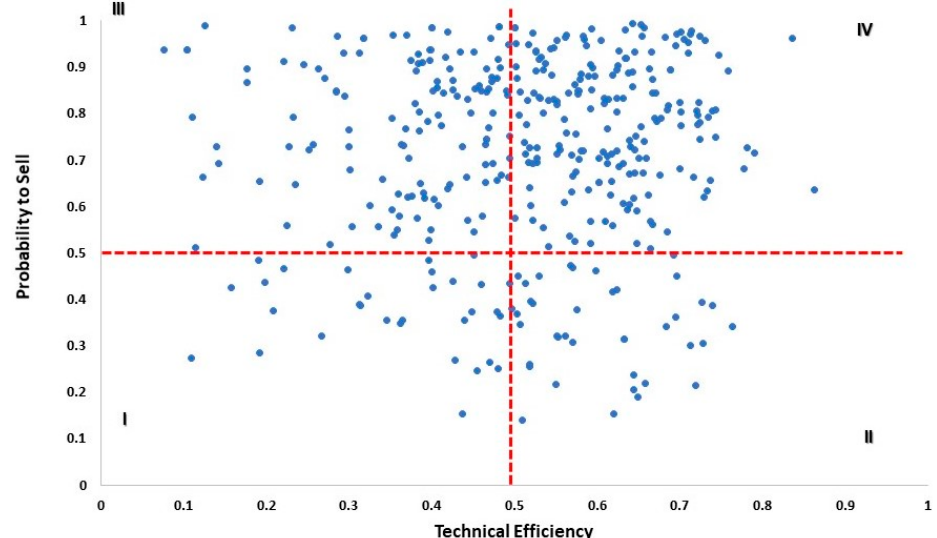
Figure 5. Correlation between technical efficiency scores and probability of selling.